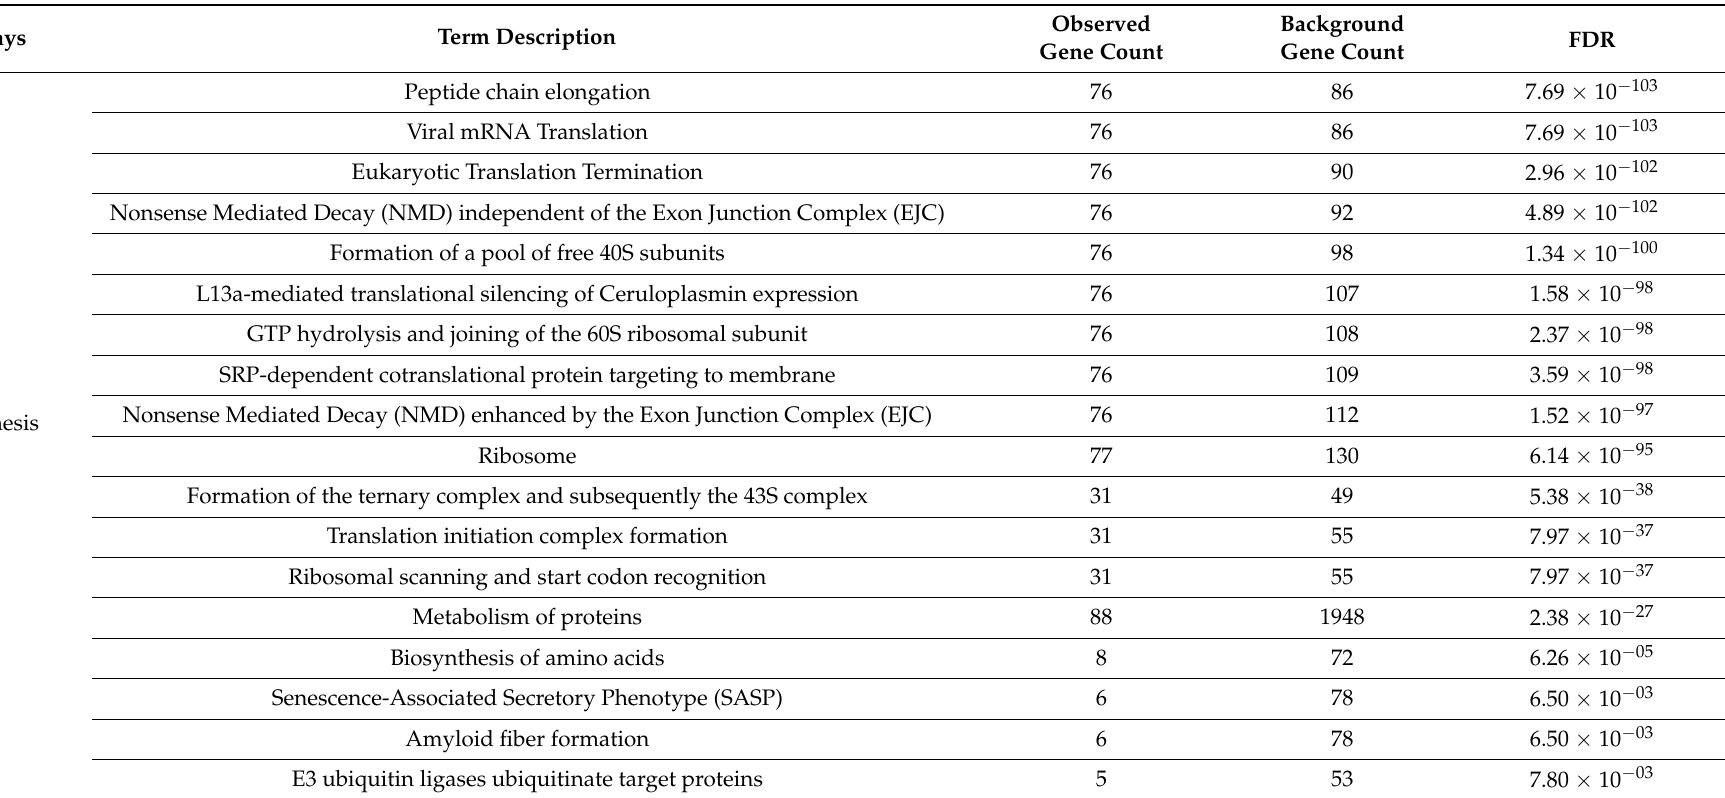
Table 3. Enriched cellular pathways influenced by Mn(II)Cit in RA-differentiated SH-SY5Y cells, after gene ontology analysis using String-db. Cell